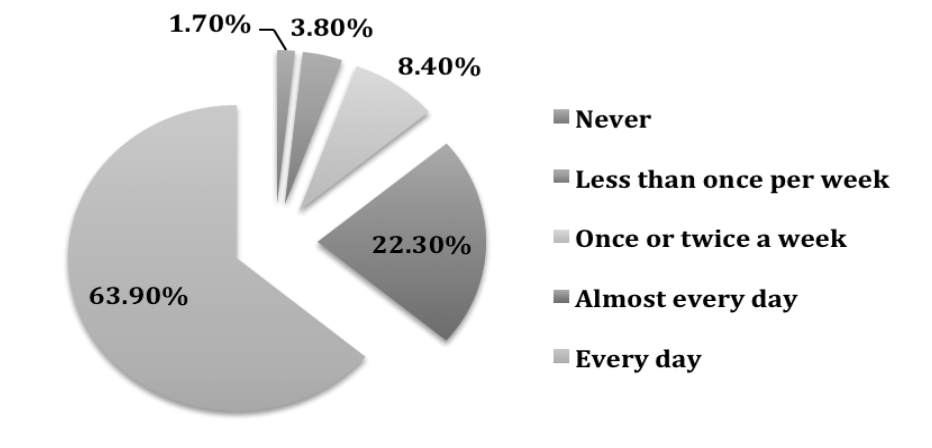
Fig. 1 . How often do you listen to music in your spare time at home?g y y p